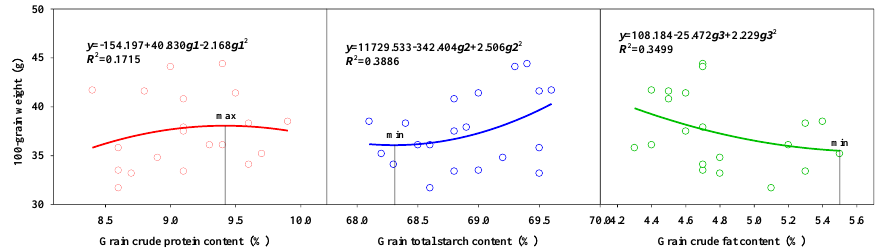
Figure 5. Regression analysis of grain nutritional quality and the 100-grain weight.